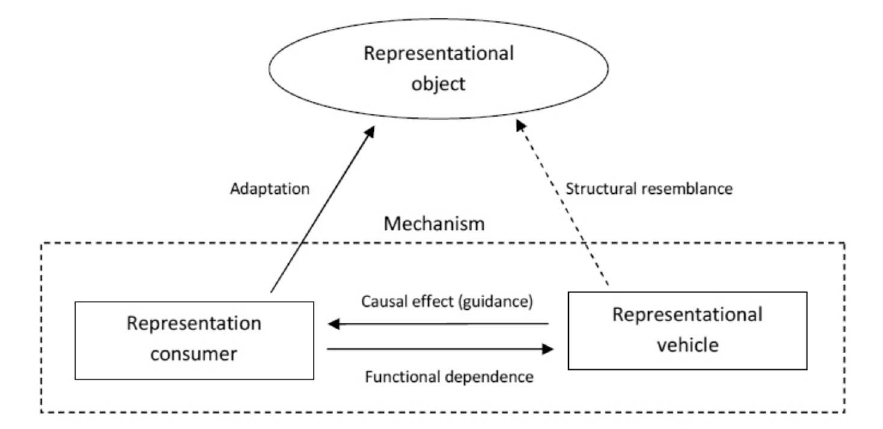
Figure 1. A schematic diagram showing the relationships between the representational vehicle, the representation consumer, and the representational object (see main text for